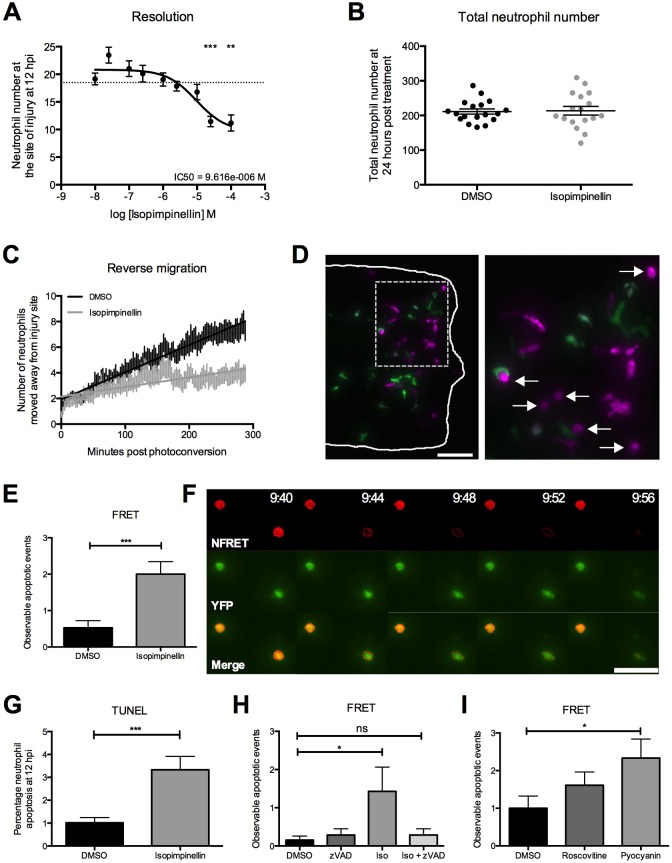
Isopimpinellin accelerates inflammation resolution in vivo by inducing neutrophil apoptosis. (A) Inflammation resolution assay in mpx:GFP larvae treated with varying doses of isopimpinellin at 6 hpi. Isopimpinellin significantly reduces neutrophil numbers at the wound at 12 hpi in a dose-dependent manner (one-way ANOVA with Dunnett's multiple-comparison post-test; **P<0.01, ***P<0.001; n=18, performed as three independent experiments). Dotted line at y=18.5 indicates mean neutrophil number at wound in DMSO control larvae. (B) Total neutrophil number measured in mpx:GFP larvae treated with DMSO or 25 μM isopimpinellin for 24 h. Isopimpinellin did not affect total neutrophil number (unpaired t-test; P=0.8696; n=18, performed as three independent experiments). (C) Reverse-migration assay in mpx/Kaede larvae treated with DMSO or 25 μM isopimpinellin from 4 hpi. Neutrophils at the site of injury were photoconverted at 6 hpi and the numbers of photoconverted cells that moved away from the wound were quantified over 5 h. Neutrophils migrated away from the wound at a slower rate in isopimpinellin-treated larvae compared to DMSO control larvae. (D) Representative image of isopimpinellin-treated mpx/Kaede larvae at 8 hpi (scale bar: 70 μm). Solid white line in the left panel indicates the outline of the tail-fin, and the boxed area is magnified in the right-hand panel. White arrows in magnified view indicate neutrophils that appear apoptotic. (E,F) FRET assay in Tg(mpx:FRET)sh237 larvae treated with DMSO or 25 μM isopimpinellin from 4 hpi and imaged from 6 hpi. Cleavage of the caspase-3 target site results in separation of the fluorophores and loss of the FRET signal (red, F). Acceptor (neutrophil) fluorescence (green, F) persists for a further 10-20 min before cell death and loss of fluorophore integrity. Time is shown as hours:minutes. Scale bar: 50 μm. Number of observable apoptotic events was increased in isopimpinellin larvae (unpaired t-test; ***P<0.001; n=18, performed as three independent experiments). (G) TUNEL assay in mpx:GFP larvae treated with DMSO or 25 μM isopimpinellin from 6 hpi and fixed at 12 hpi. Numbers of TSA-positive neutrophils and TSA/TUNEL double-positive apoptotic neutrophils at the site of injury were measured to calculate percentage neutrophil apoptosis, which was increased in isopimpinellin-treated larvae (unpaired t-test; ***P<0.001; n=115, performed as two independent experiments). (H) Larvae were treated with DMSO, 100 μM Z-VAD-FMK (zVAD), 25 μM isopimpinellin (Iso) or in combination (Iso+zVAD) from 4 hpi and imaged from 6 hpi. Number of observable apoptotic events was increased with isopimpinellin alone but the effect was lost with the addition of Z-VAD-FMK (one-way ANOVA with Bonferroni's multiple-comparison post-test to compare selected columns; *P<0.05; ns, non-significant; n=14, performed as three independent experiments). (I) Larvae were treated with DMSO, 20 μM roscovitine or 50 μM pyocyanin from 4 hpi and imaged from 6 hpi. Number of observable apoptotic events was increased with pyocyanin (one-way ANOVA with Bonferroni's multiple-comparison post-test to compare selected columns; *P<0.05; n=18, performed as three independent experiments).